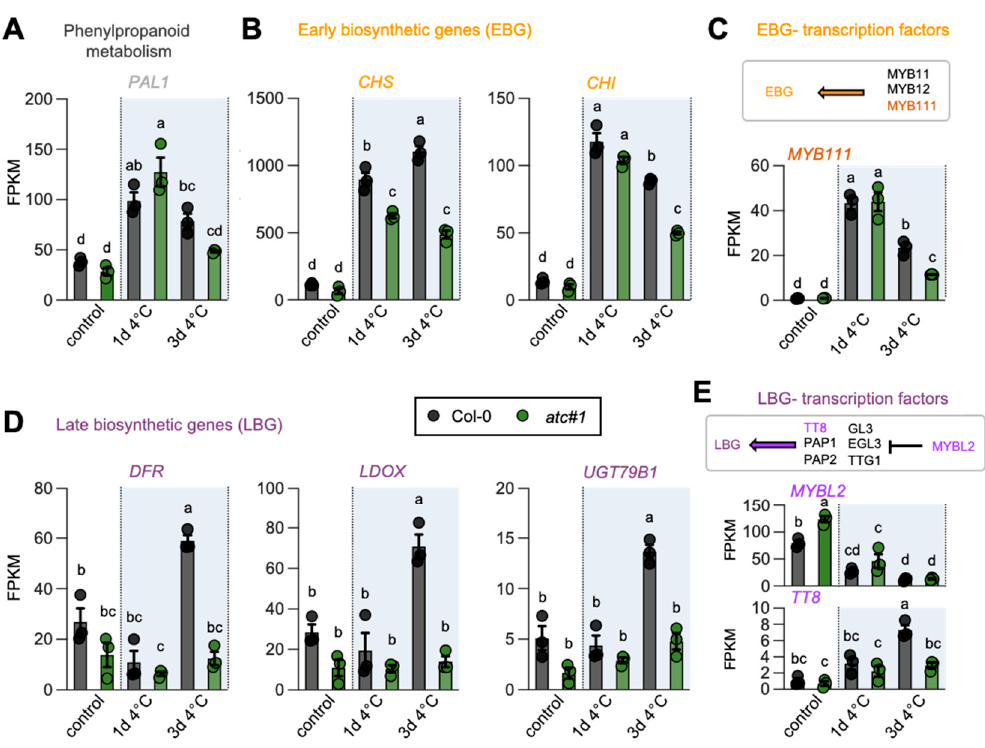
Figure 5. Global transcript alterations ( atc#1 vs. Col-0) in flavonoid biosynthesis genes. Data points and means +/ − standard deviation of FPKM values are shown. Di ff erent le tt ers denote signi fi cant differences according to a two-way ANOVA with post-hoc Tukey HSD testing ( p < 0.05). Phenylalanine ammonia-lyase (PAL1), chalcone synthase (CHS), chalcone isomerase (CHI), dihydroflavonol-4-reductase (DFR), leucoanthocyanidin dioxygenase (LDOX), cyanidin 3-O-glucoside 2 ″ -O-xylosyltransferase (UGT79B1), Arabidopsis MYB transcription factors (MYB111 and MYBL2) and transparent testa8 (TT8)